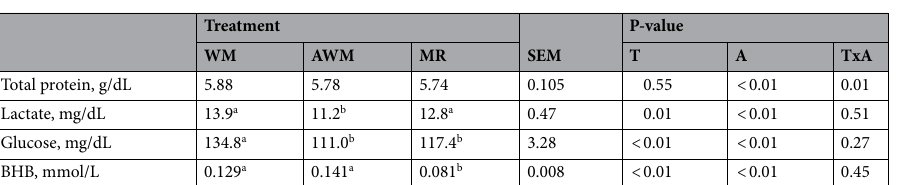
Table 2. Blood metabolites of preweaning dairy calves fed different liquid diets. 1 WM whole milk, AWM acidified whole milk, MR milk replacer, SEM standard error of the mean, T treatment effect, A age effect, T × A treatment × age interaction effect ( P < 0.05), TSP total serum protein. a , b Means within a row with different superscripts are significantly different (P ≤